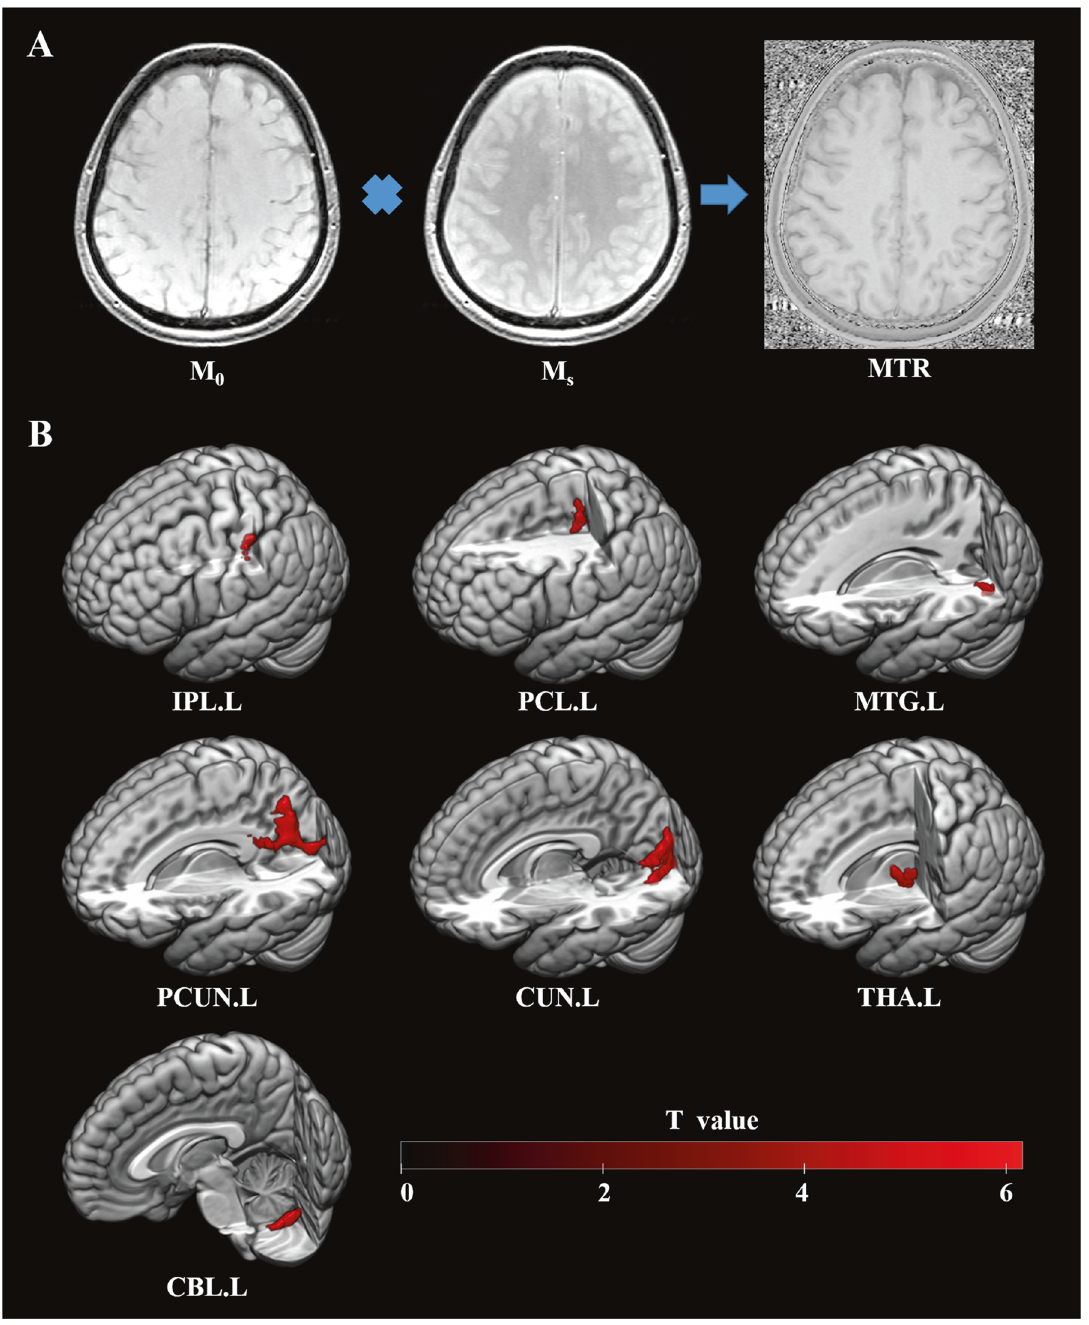
Fig. 1 MTR in voxel-based differences between individuals with fi rst-episode schizophrenia and healthy controls. A Schematic illustration of MTR calculated on a voxel-by-voxel basis as MTR = 100 × (M 0 – M S )/M 0 , where M 0 and M S represent the signal intensities without and with the saturation pulse; B Signi fi cant clusters were identi fi ed in individuals with fi rst-episode schizophrenia compared to healthy controls based on a voxel-level statistical threshold of P < 0.05 (family-wise error corrected, cluster size > 40). The color bar indicates T values. MTR magnetization transfer ratio, L left, CUN cuneus, PCUN precuneus, MTG middle temporal gyrus, IPL inferior parietal lobule, THA thalamus, CBL cerebellum, PCL paracentral this may re fl ect the difference between acute psychosis and persistent illness, and/or drug treatment effects. Diffusion tensor imaging studies in individuals with FES compared with HCs report lower FA in the left temporal areas [38]; this is not necessarily discrepant from our fi nding of higher MTR, because the two techniques measure different things: diffusion tensor imaging, responding to the orientation of water diffusion along anatomical compartments, re fl ects the spatial organization of fi ber tracts,